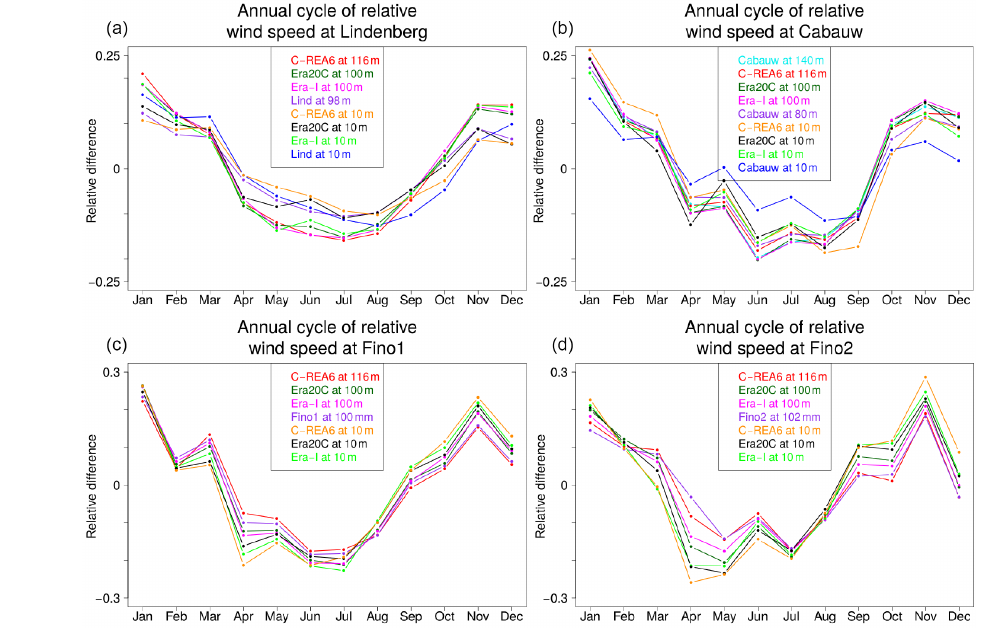
Figure 6. Annual cycle of relative monthly wind speed (anomaly) of 10 and 100m at Lindenberg (top left), Cabauw (top right), FINO1 (bottom left), and FINO2 (bottom